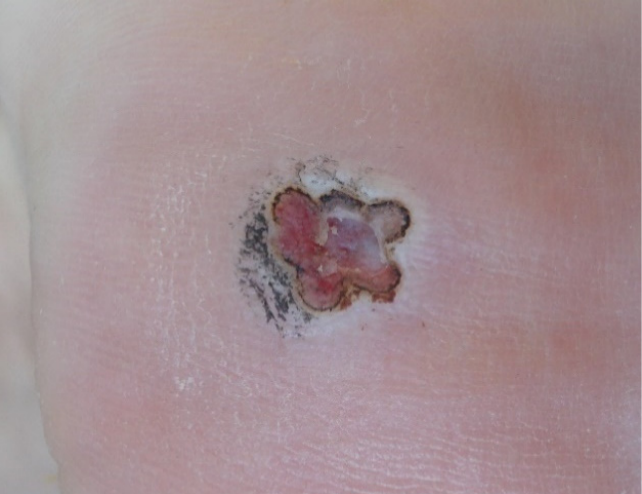
Figure 4. A plantar wart >4 mm in diameter one week after treatment.